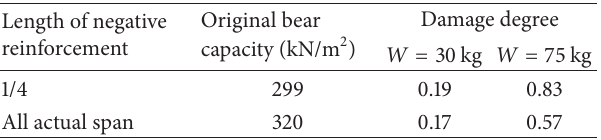
Table 2: Damage degree of RC slab under different reinforcement